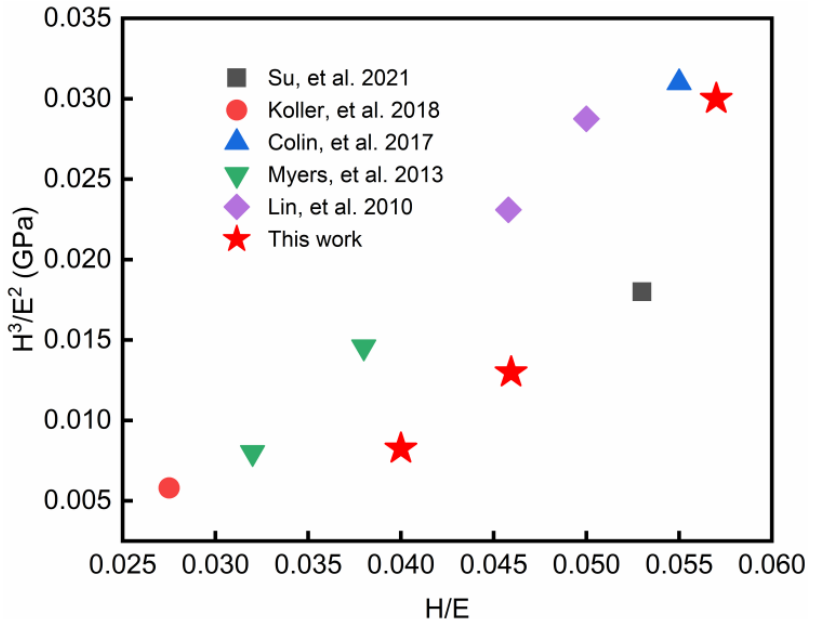
Figure 8. Comparison of the H/E and H 3 /E 2 of α-Ta coatings with other literatures [15,21,32–34].